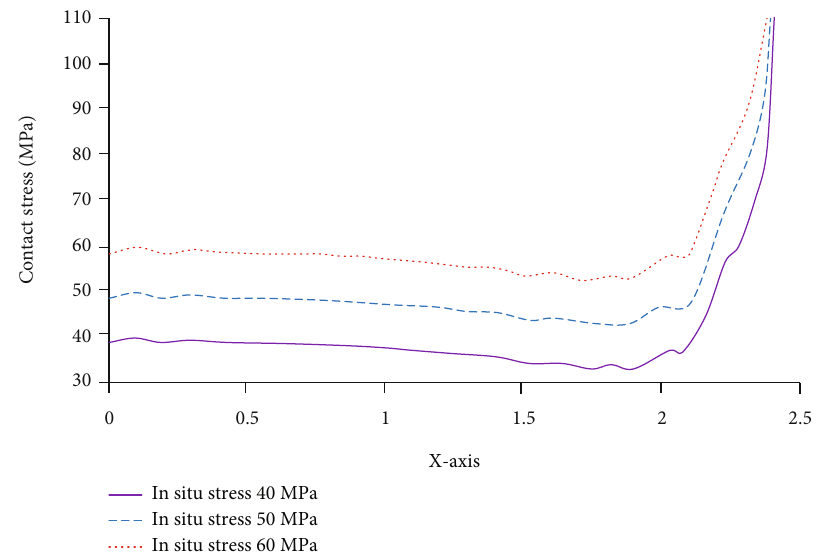
Figure 28: Comparison of contact stress of proppant under di ff erent in situ stresses (elastic modulus